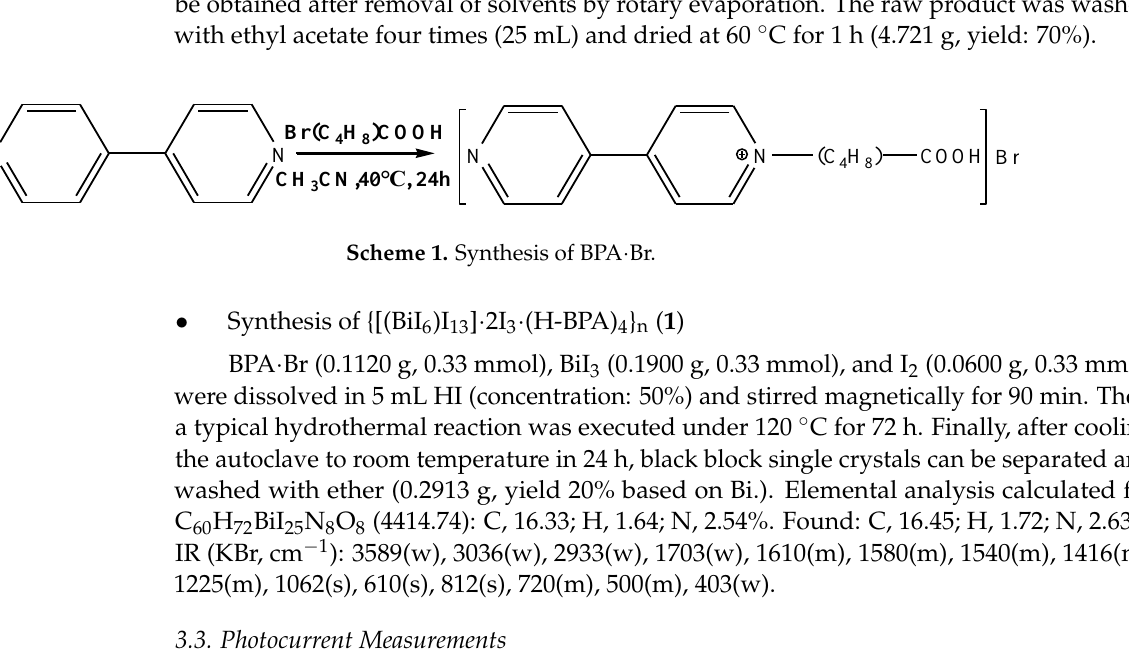
Figure 5. ( a ) Time-dependent UV−Vis spectra of RhB with the presence of 1 as catalyst; ( b ) Degra- dation ratio of RhB different irradiation time with or without the presence of catalyst; ( c ) Recycling tests of 1 for RhB photodegradation under light